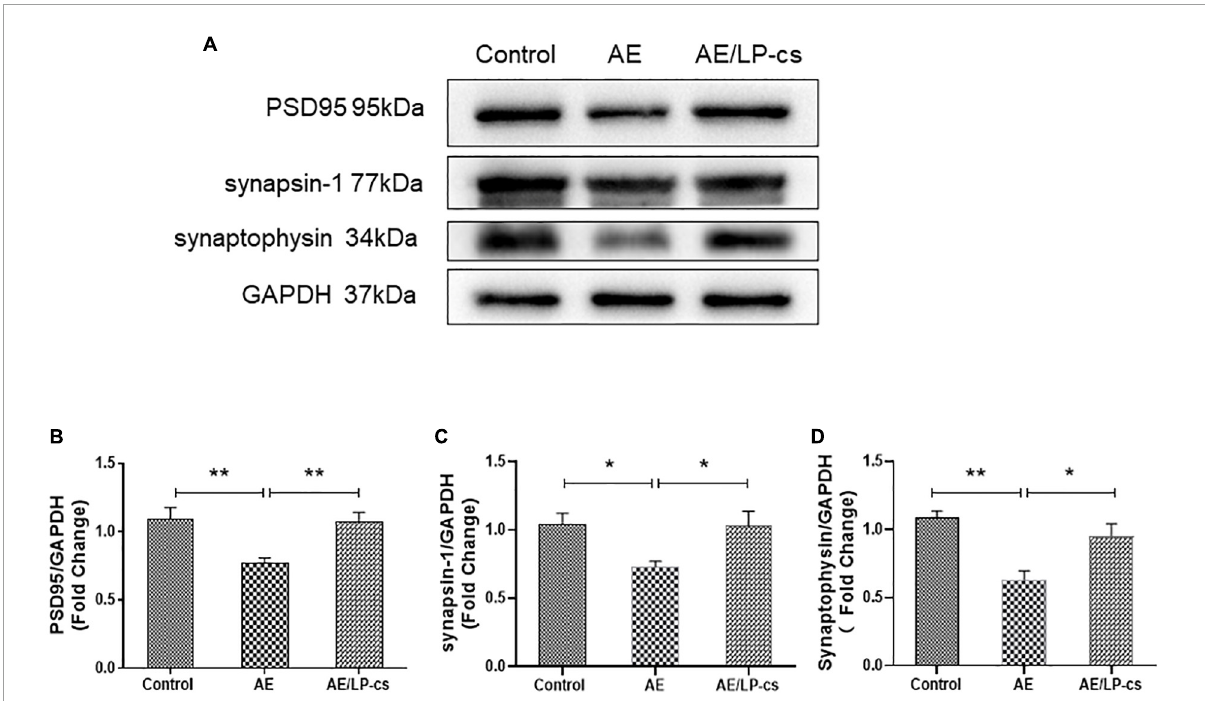
FIGURE4 Lactobacillus plantarum culture supernatants relieves alcohol-induced downregulation of synapse-related proteins. (A–D) Western blot and quantitative analysis of PSD95, synaptophysin, and synapsin-1 expressions in the hippocampus from the mice. Control vs. AE and AE vs.